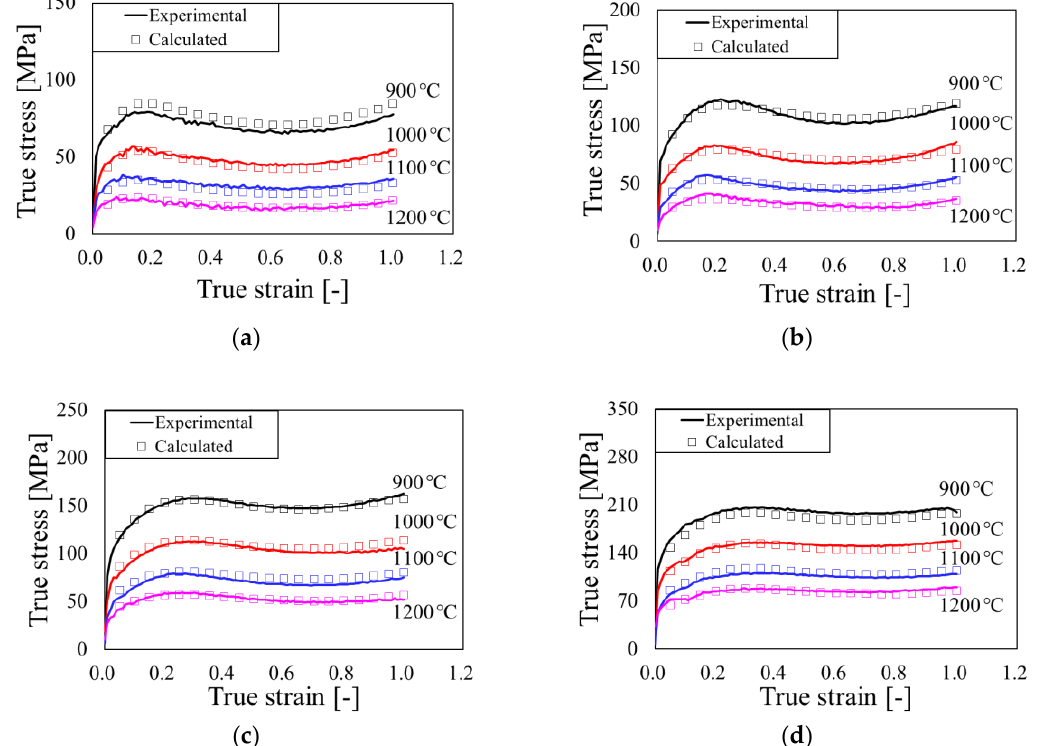
Figure 7. Calculated values and experimental values under different deformation conditions are compared. ( a ) 0.01 s − 1 ; ( b ) 0.1 s − 1 ; ( c ) 1 s − 1 ; ( d ) 10 s − 1 .